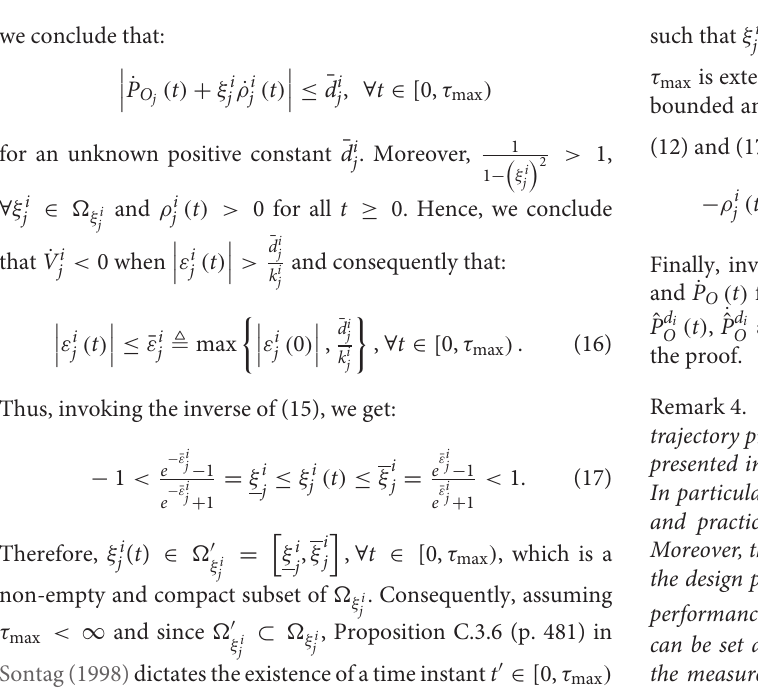
FIGURE 9 | Two mobile manipulators handling a rigidly grasped object in a constrained workspace with static obstacles. Only the leader is aware of the object’s desired configuration and the obstacles’ position in the